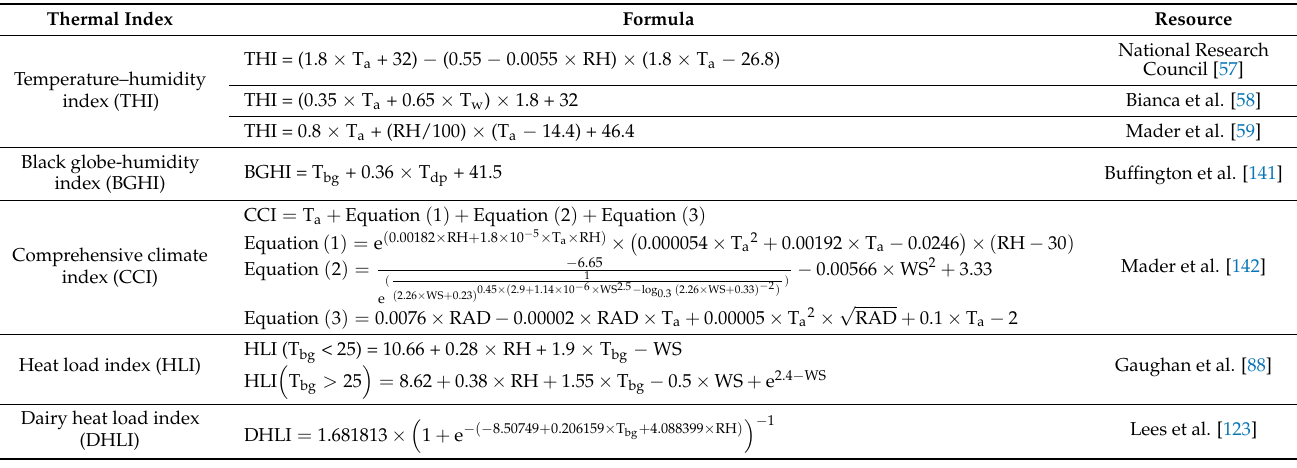
Table 5. Summary of the thermal indices mentioned in this